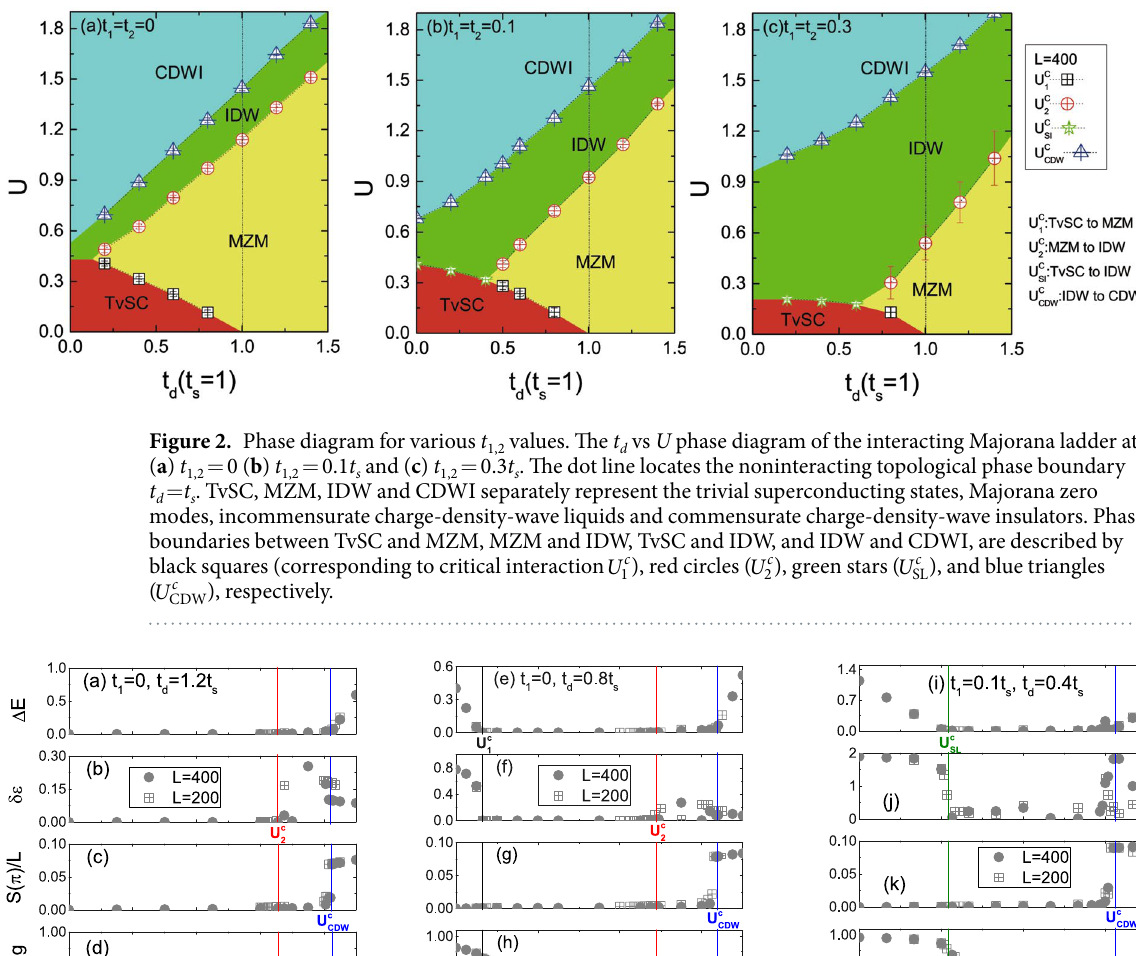
Figure 3. Key physical quantities vs U . From top to bottom rows: energy gap Δ E , quantity characterizing entanglement-spectrum degeneracy δε , charge structure factor at q = π (per length) S ( π )/ L , and filling of fermions n , respectively. From left to right columns: ( a – d ) t 1,2 = 0 and t d = 1.2 t s , ( e – h ) t 1,2 = 0 and t d = 0.8 t s , and ( i – l ) t 1,2 = 0.1 t s and t d = 0.4 t s ,